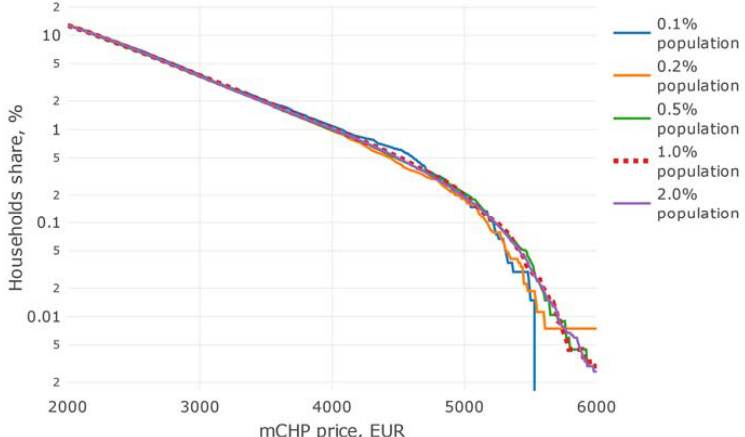
Figure 10. Share of households for which economic viability was achieved in the function of mCHP price (for EPI = 1.0 and GPI = 1.0) and depending on the sample size from the population.